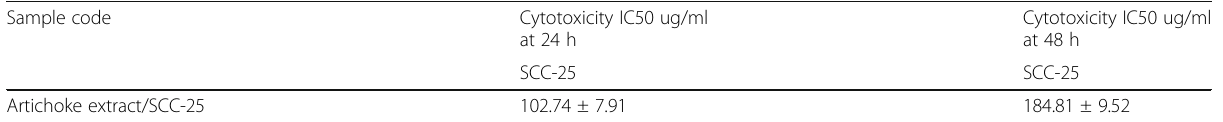
Table 2 Mean values and variability of measures (SD) of cytotoxicity of artichoke extract on SCC-25 cell lines at 24 and 48 h using paired samples Student ’ s t test Sample